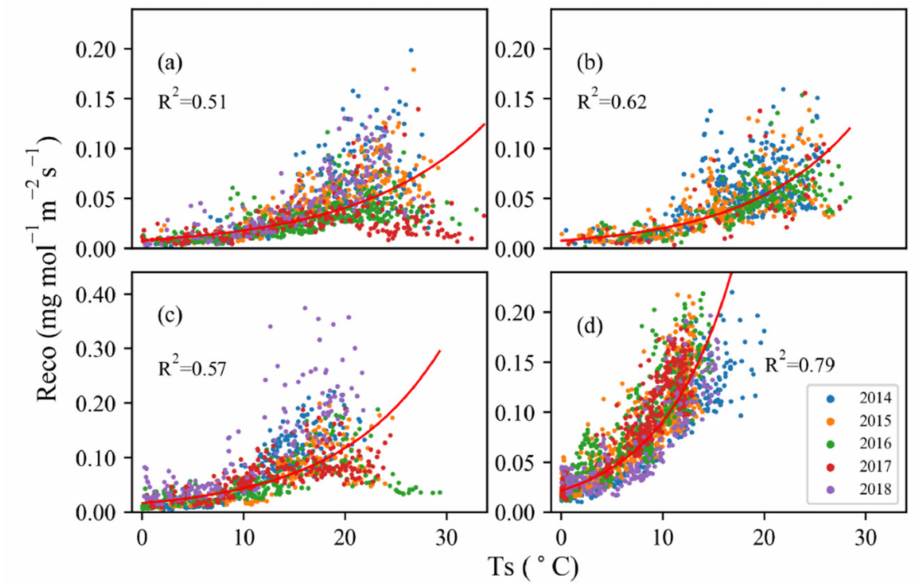
Figure 3. Response of nighttime ecosystem respiration (R eco ) to soil temperature (Ts) for four sites in different years: ( a ) SHB, 2014–2018, ( b ) DRY, 2014–2017, ( c ) TEMP, 2014–2018, ( d ) MDW, 2014–2018. The R-squares were obtained considering the whole years. According to exponential function, the regressions are 0.008 e 0.0814Ts for site SHB, 0.0077 e 0.0967Ts for site DRY, 0.0163 e 0.0998Ts for site TEMP and 0.0217 e 0.1431Ts for site